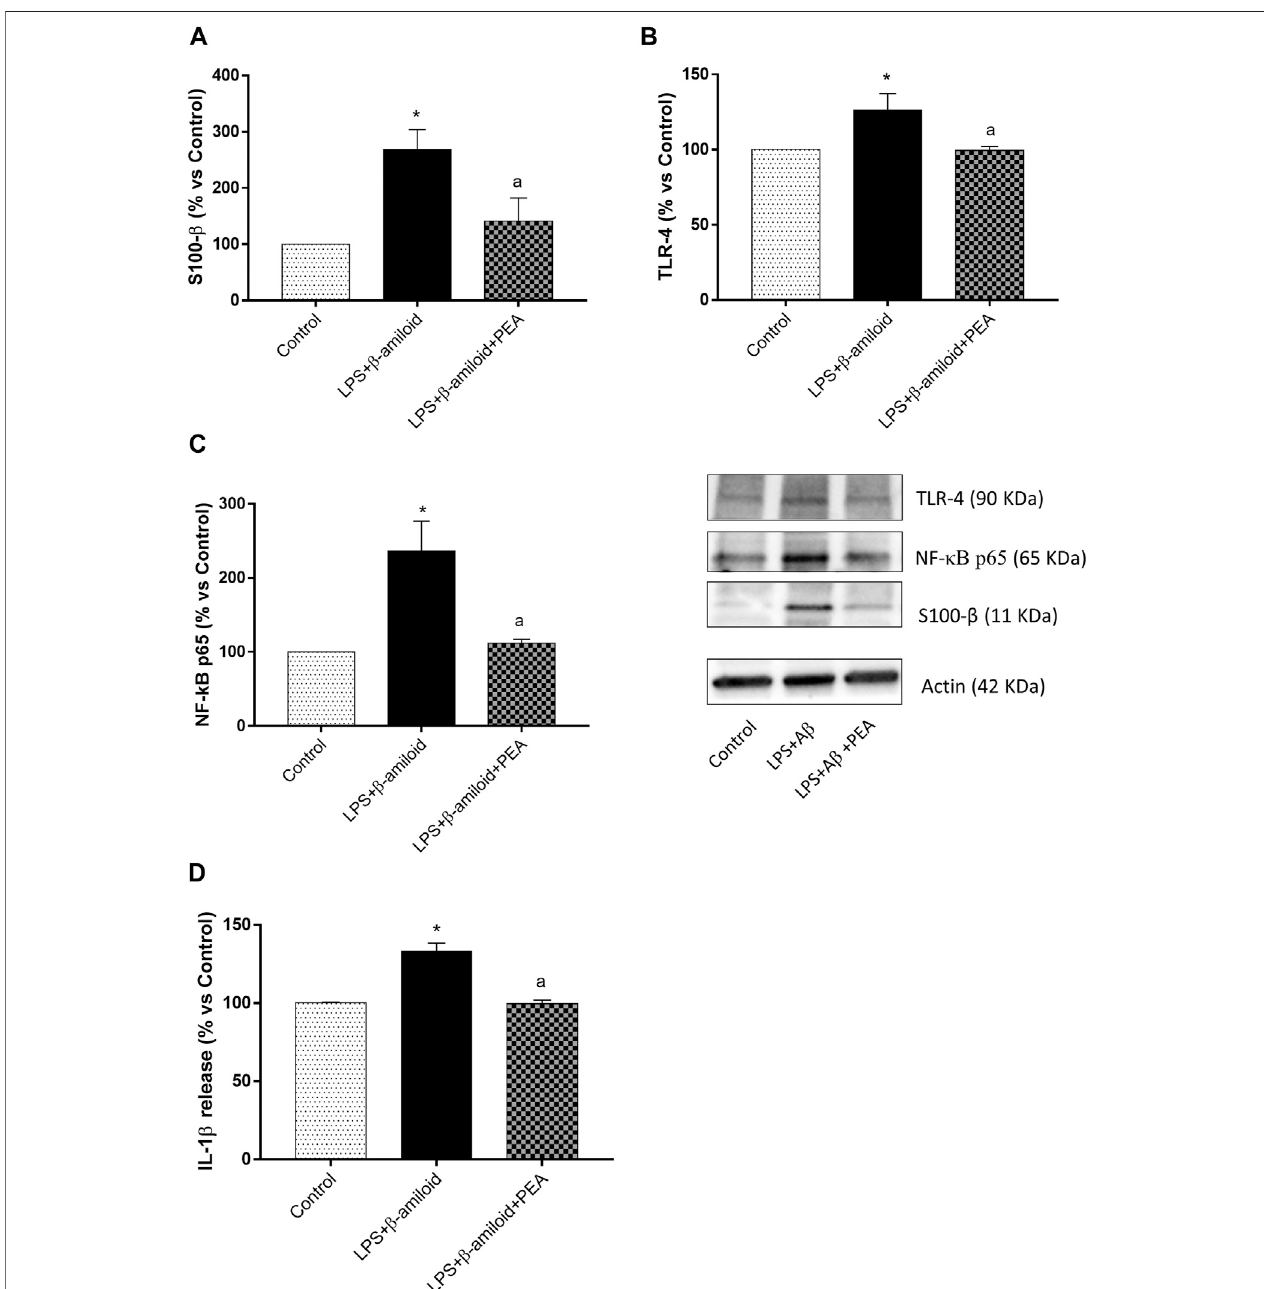
FIGURE 6 | PEA blunts glial pro-in fl ammatory responses. Representative blots and densitometric analysis of the expression of (A) S100- β , (B) TLR-4 and (C) NF- κ B p65 assessed by Western blot assay in cultured EGCs treated with LPS plus A β , either alone or in combination with PEA. Each column represents the mean ± SEM ( n (cid:1) 4). (D) IL-1 β levels in the supernatants of EGCs treated with LPS plus A β , either alone or in combination with PEA. Each column represents the mean ± SEM ( n (cid:1) 4). One-way ANOVA followed by Tukey post hoc test results: * p < 0.05, signi fi cant difference vs. SAMR1 and a p < 0.05, signi fi cant difference vs. SAMP8.; Abbreviations : EGC, enteric glial cell; IL-1 β , interleukin-1 β ; NF- κ B p65, nuclear factor- κ B p65; PEA, palmitoylethanolamide; S100- β , S100 Calcium Binding Protein B; TLR-4, Toll-like Receptor